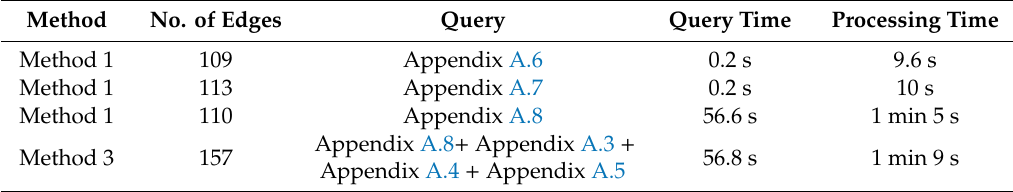
Figure 10. Navigation network derived from the IFC dataset by applying the third method. Table 3. Results of processing of the 3D cadastral datasets for the third method.